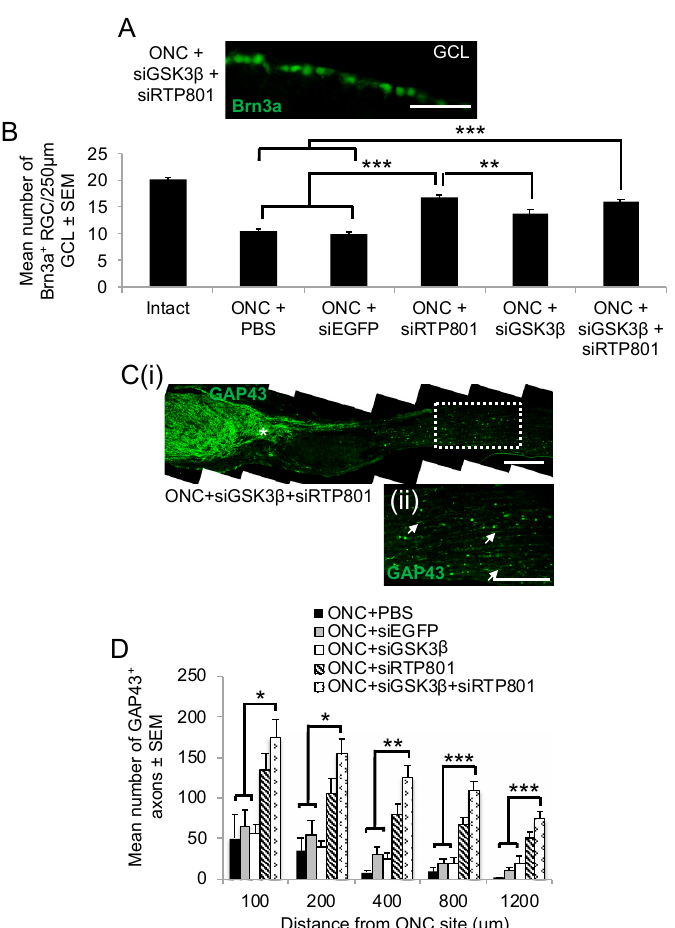
Figure 9. The effect of combined siGSK3 β + siRTP801 on RGC survival and axon regeneration 24 days after ONC. Although ( A ) many Brn3a + RGC were present after combined siGSK3 β + siRTP801 treatment, ( B ) quantification of the number of RGC / 250 µ m GCL did not show any additive or synergistic e ff ects of both siRNAs, despite individual and combination treatments being equally RGC